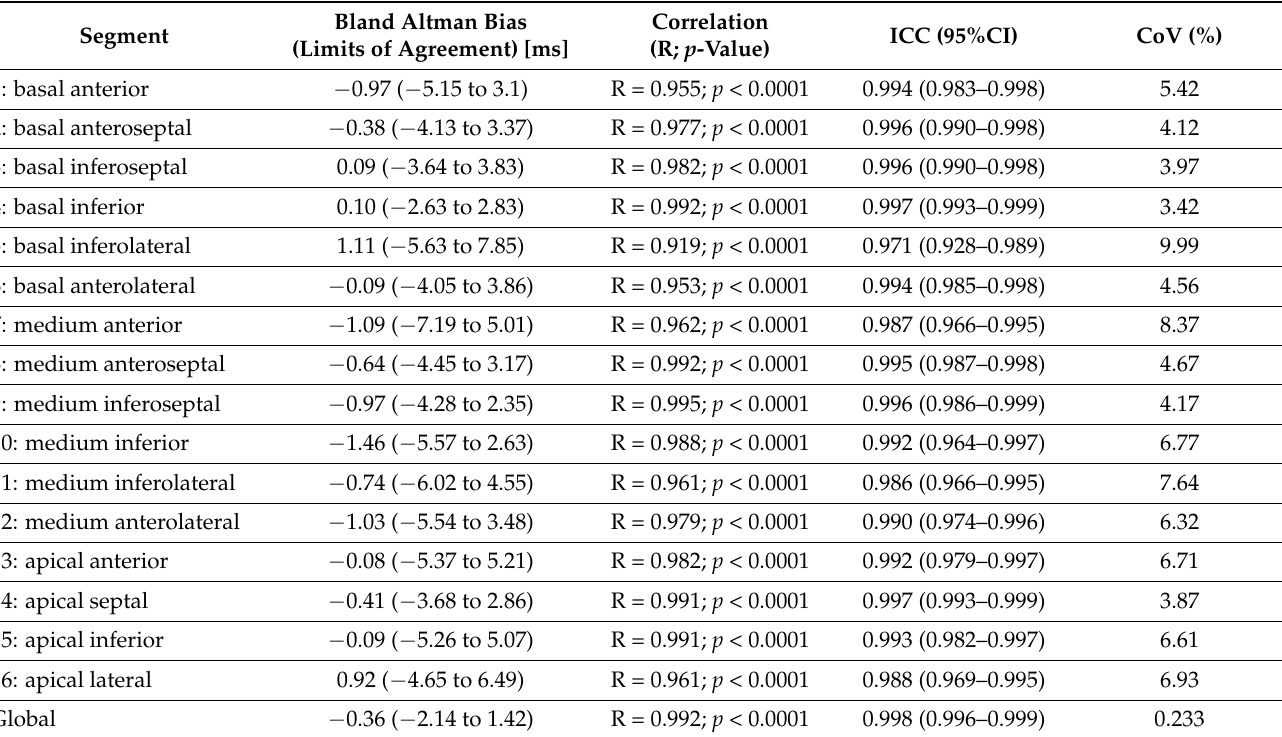
Table 2. Agreement between T2* values obtained with the manual and the DL-based methods in the test cohort.